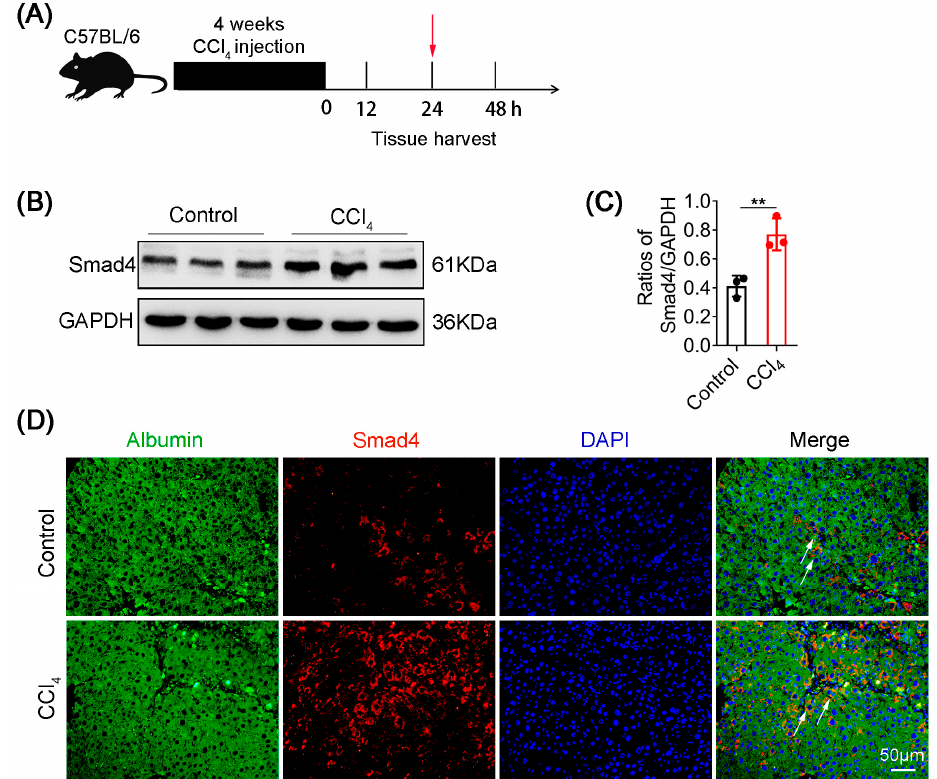
Figure 1. Smad4 expression is upregulated in hepatocytes during liver fibrosis. Groups of C57BL/6 mice were treated with CCl 4 for 4 weeks to establish a liver fibrosis model ( n = 6 per group). Data represent at least three independent experiments. ( A ) Schematic representation of CCl 4 -induced liver fibrosis. ( B , C ) Western blotting analysis of Smad4 protein levels in liver fibrosis tissues. Smad4 expression was normalized to the control GAPDH. ( D ) Double staining of albumin (green) and Smad4 (red) in liver fibrosis tissues (scale bars: 50 μ m). Arrowheads indicated the double-positive cells. ** p < 0.01.